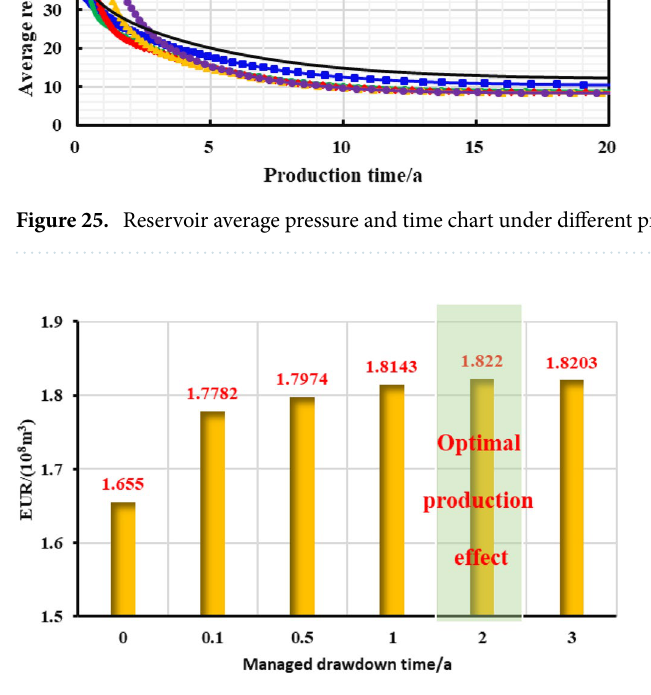
Figure 26. EUR changes under different pressure control